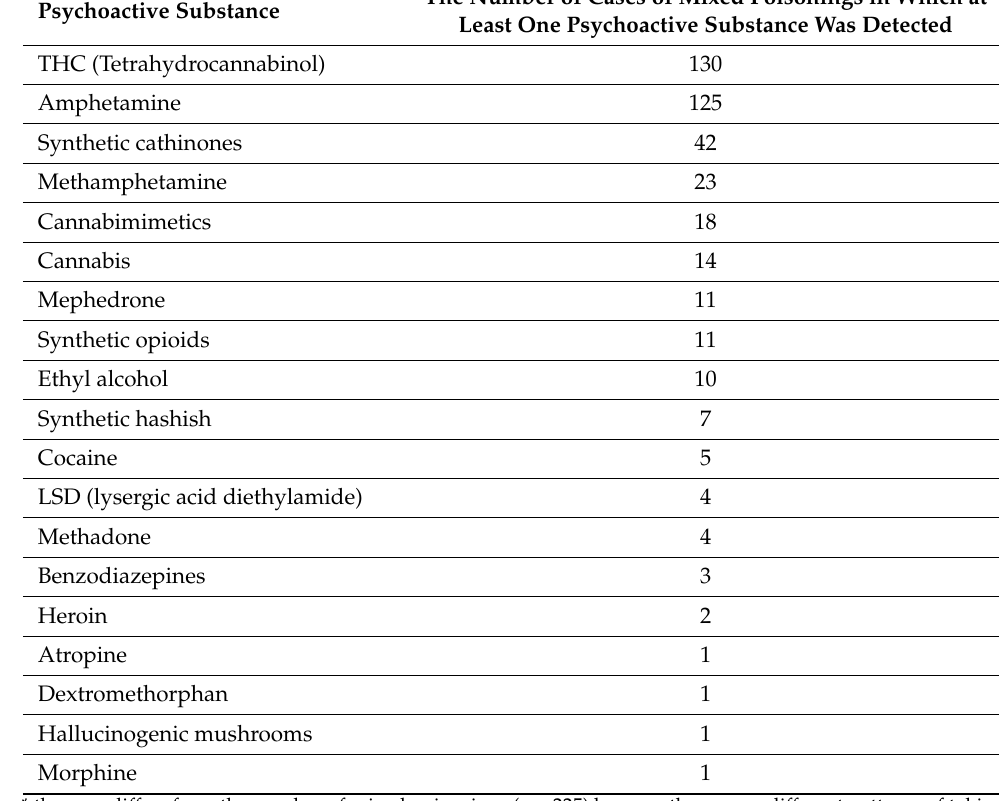
Table 4. List of psychoactive substances in mixed poisonings ( n = 225) *. Psychoactive